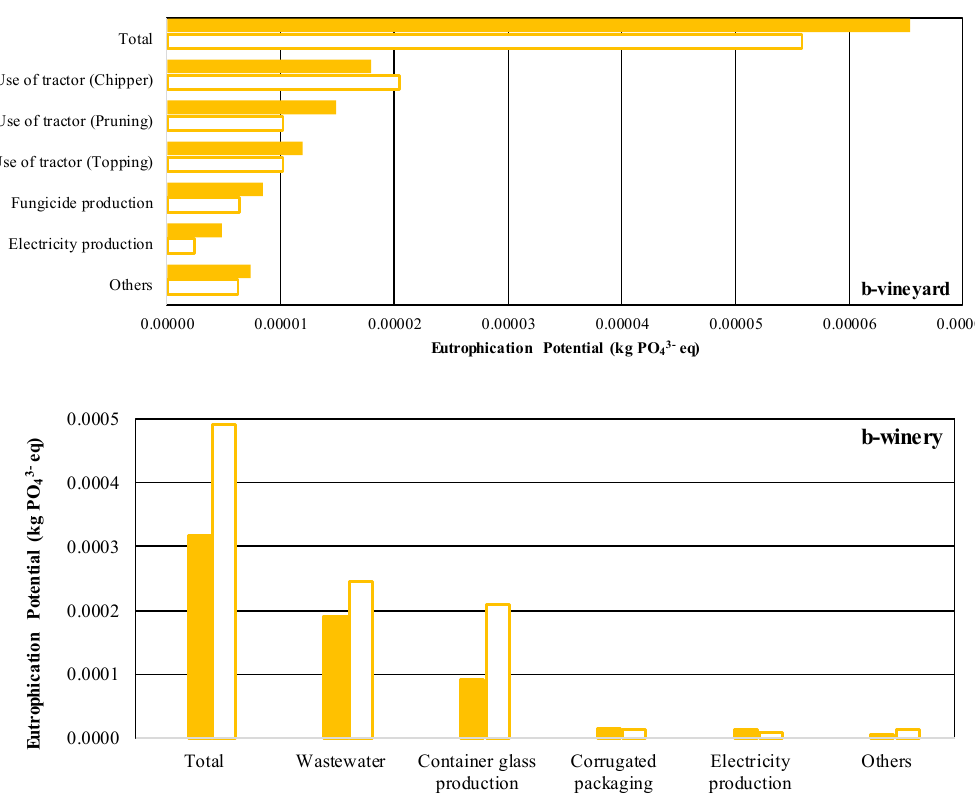
Figure 14. Total results for the potential for ( a ) acidification and ( b ) eutrophication for the vineyard and winery stages in case study I (filled bars) and case study II (unfilled bars).